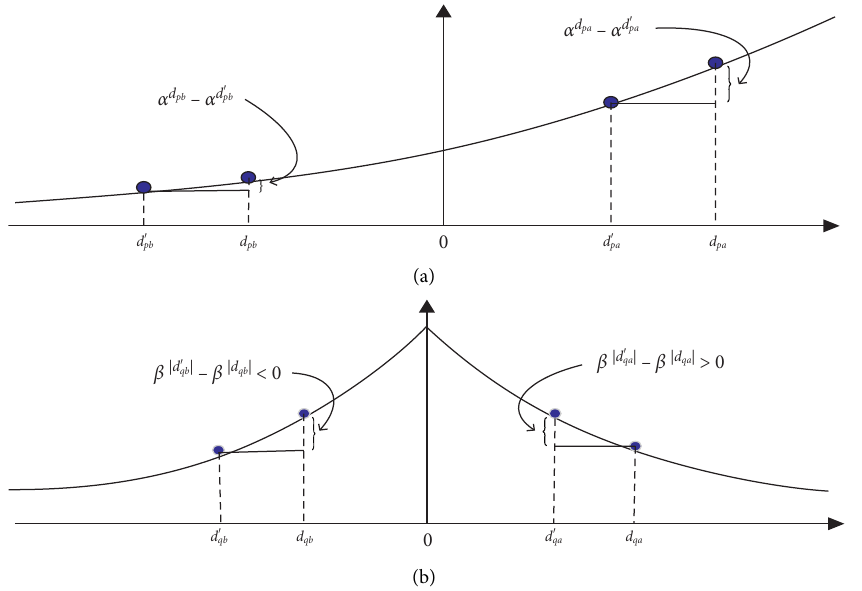
Figure 1: (a) Area divided. (b) Area of E